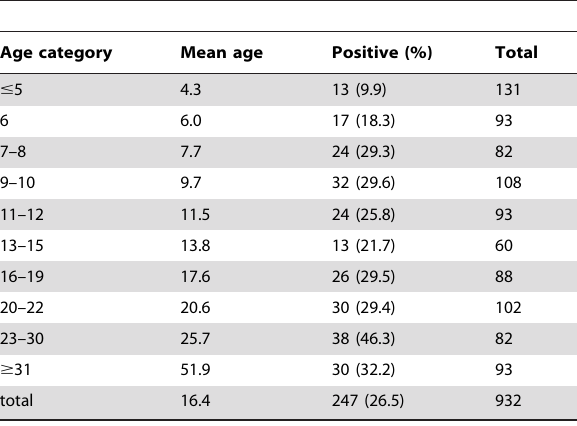
Table 1. Wild boar serum samples positive for antibodies against T. gondii and mean age (months) by age category.